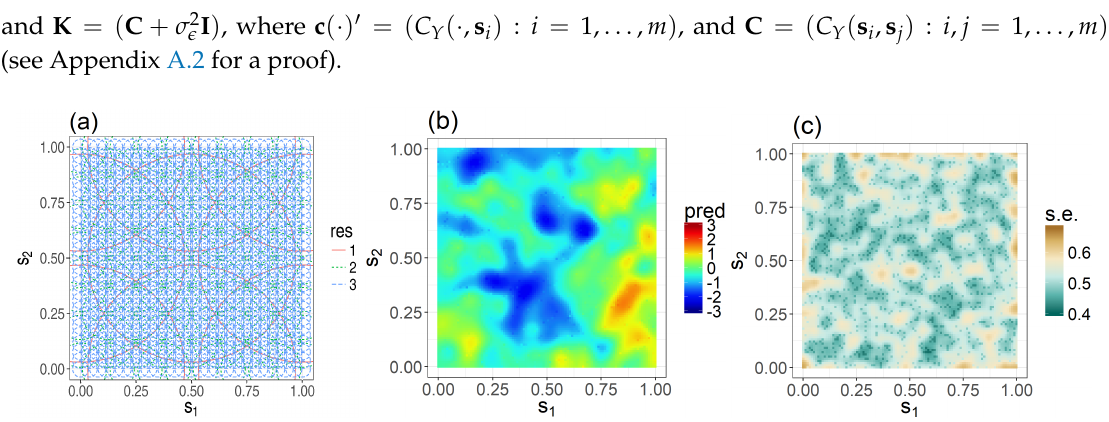
Figure 3. Fixed rank kriging (FRK) in a simulation experiment (see the text of Section 2.3 for details). ( a ) Arrangement of multi-resolution basis functions: the red solid line, green dotted line and blue dashed line denote the first, second and third resolution of the basis functions, respectively. ( b ) The prediction (pred) following FRK on the prediction grid using the simulated retrievals. ( c ) The prediction standard errors (s.e.) following FRK on the prediction grid using the simulated retrievals.